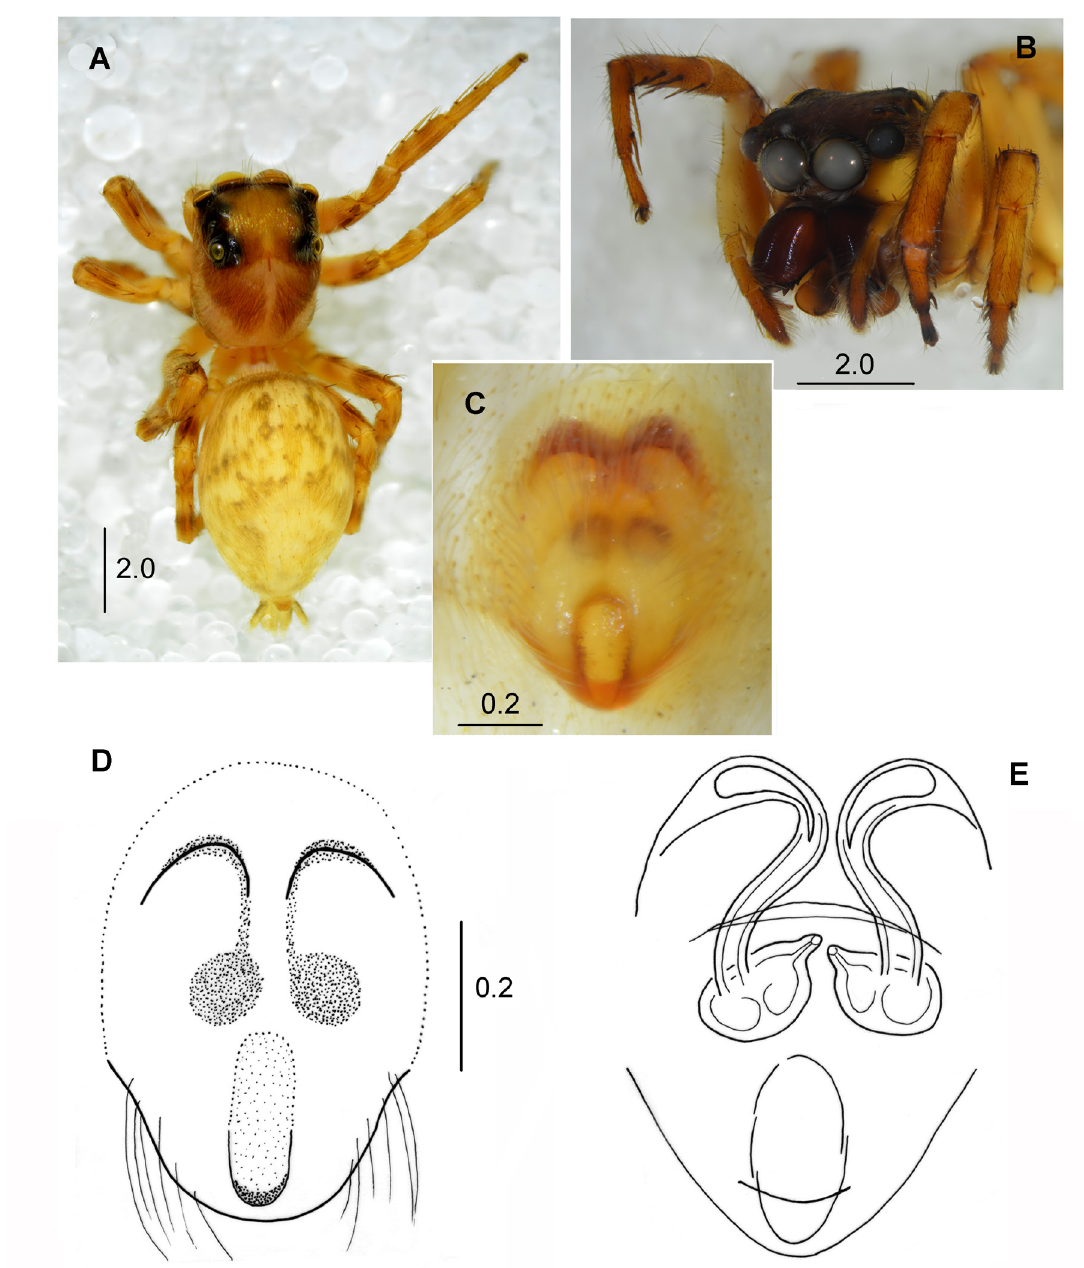
Fig. 65. Thiratoscirtus gambari Wesołowska & Russell-Smith, 2011,♀ (MNHN). A . Habitus, dorsal view. B . Frontal view. C–D . Epigyne. F . Internal structure of